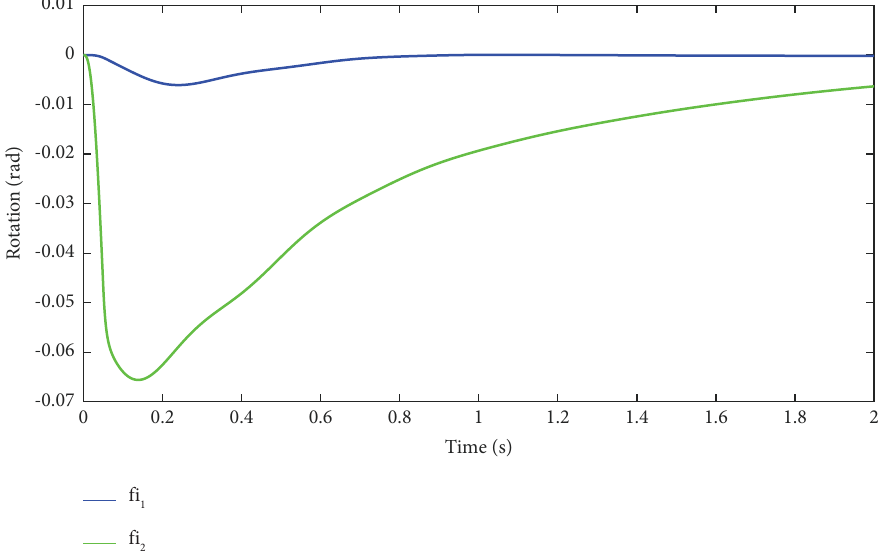
1 -angular displacement of the vehicle’s